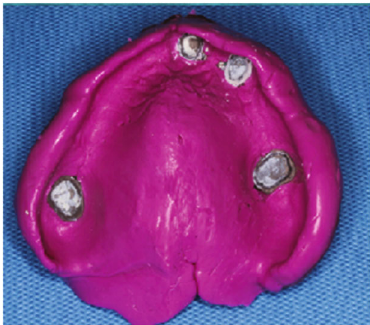
Figure 14: Metal ceramic crown on (FDI 44).